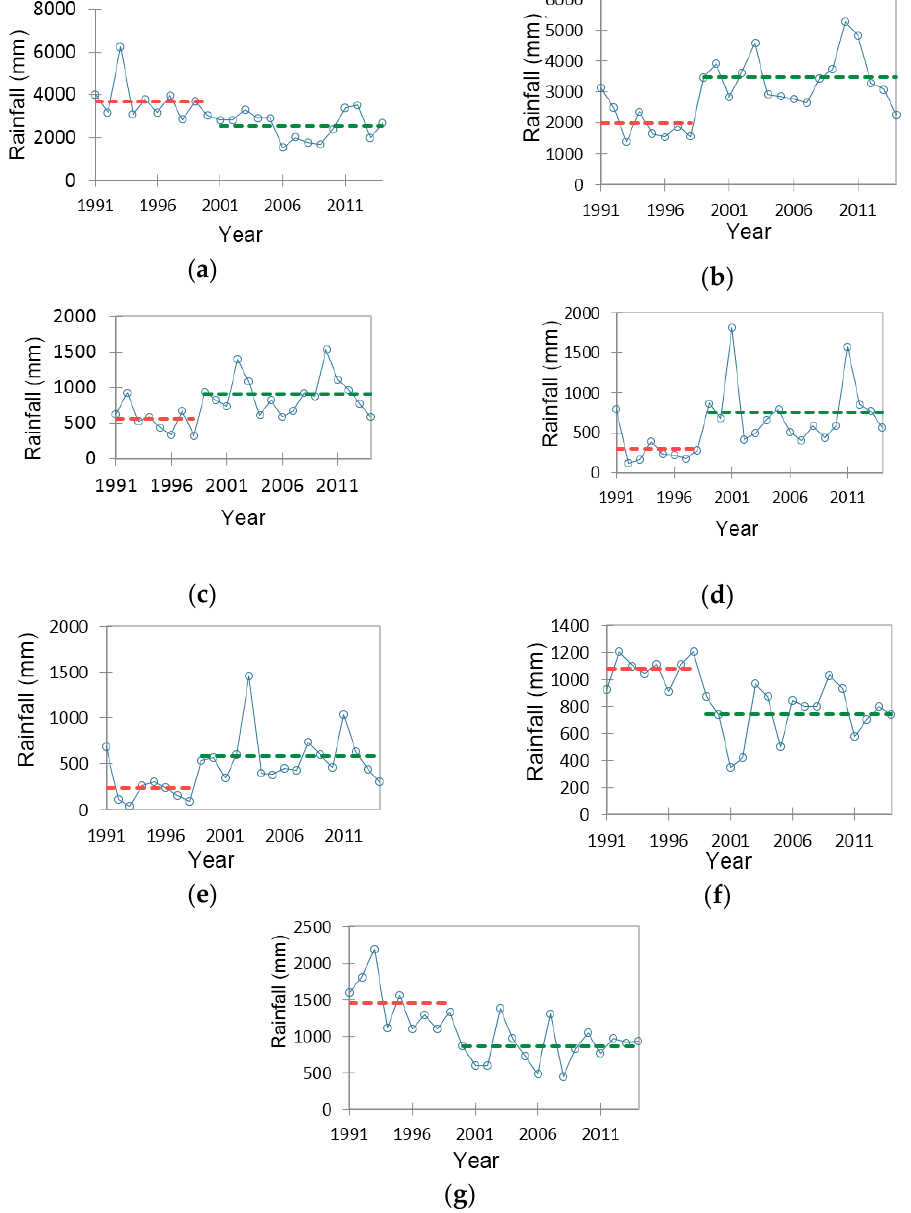
Figure 3. Pettitt’s test results of the annual and seasonal rainfall data: ( a ) Deniyaya annual, ( b ) Dampahala annual, ( c ) Dampahala SIM, ( d ) Dampahala NEM, ( e ) Dampahala FIM, ( f ) Kamburupitiya SWM, and ( g ) Deniyaya SWM.